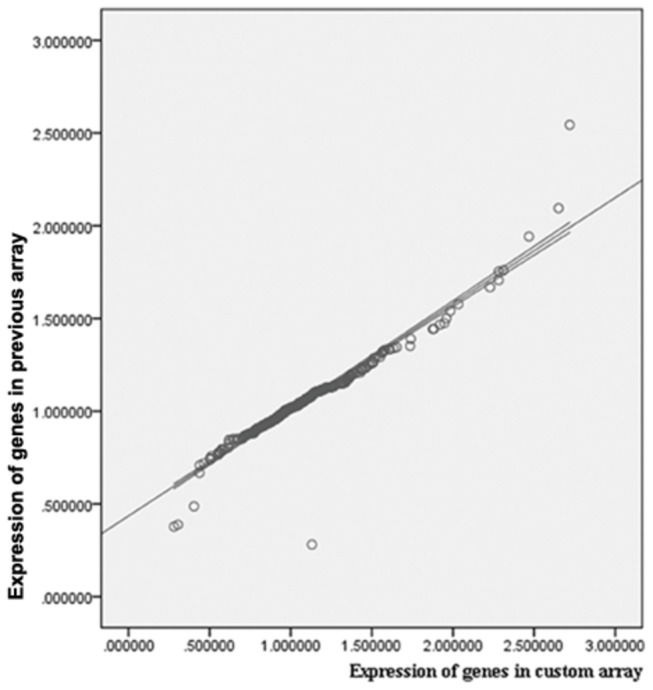
Expression data of custom microarray compared to previous study of the whole genes array with the same patient.The data indicated the expression ratio of malignant/premalignant. There were no significant differences between two groups.